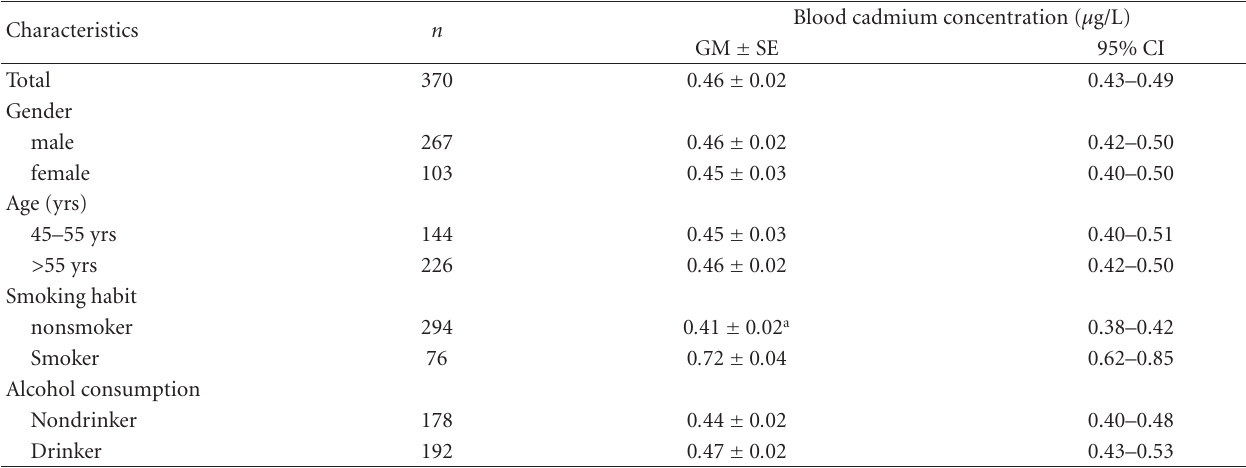
Table 1: The geometric mean of blood cadmium concentrations in a nonoccupational exposed population.